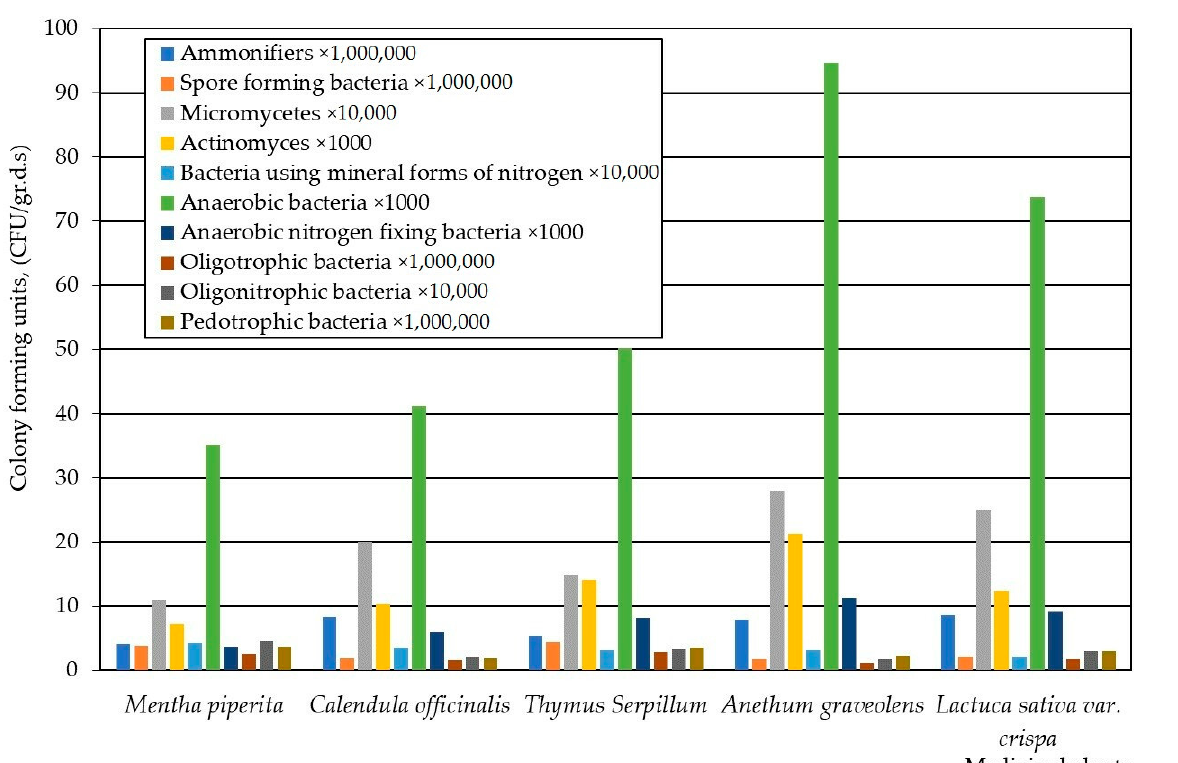
Figure 5. Microbial community composition (CFU/gr.d.s.) in soils of agroecosystems contaminated by antibiotics. The data are statistically significant, p < 0.05, x ± SD, n = 4.